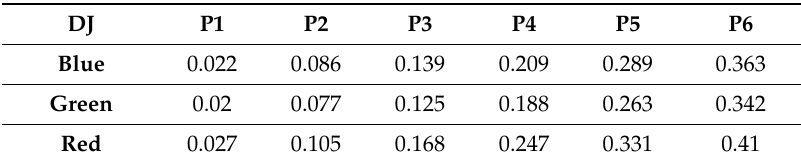
Figure 2. Placement of the calibration panels (from P1 to P6) during image acquisition. Table 1. Reflectance measurements for each band of the DJI (DJI, Shenzhen, China) camera for panels P1 to